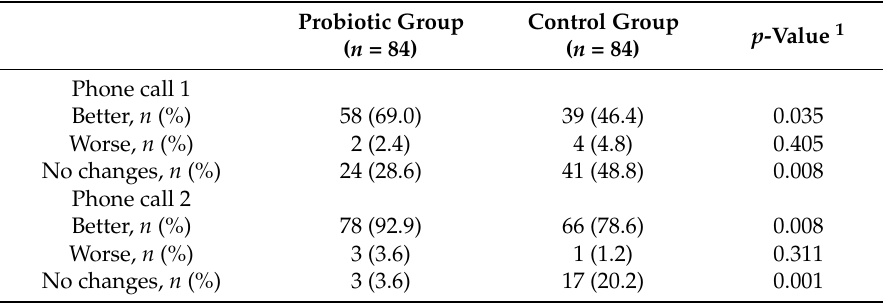
Table 5. Parental impression of colic during the